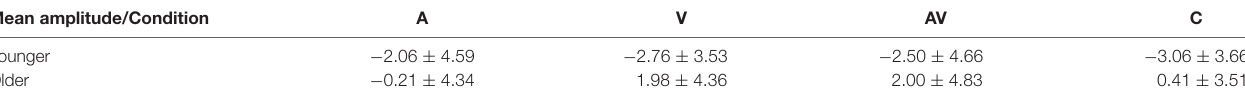
TABLE 1 | Mean amplitude of P2 in four conditions (A, V, AV and C) for younger and older participants. Mean